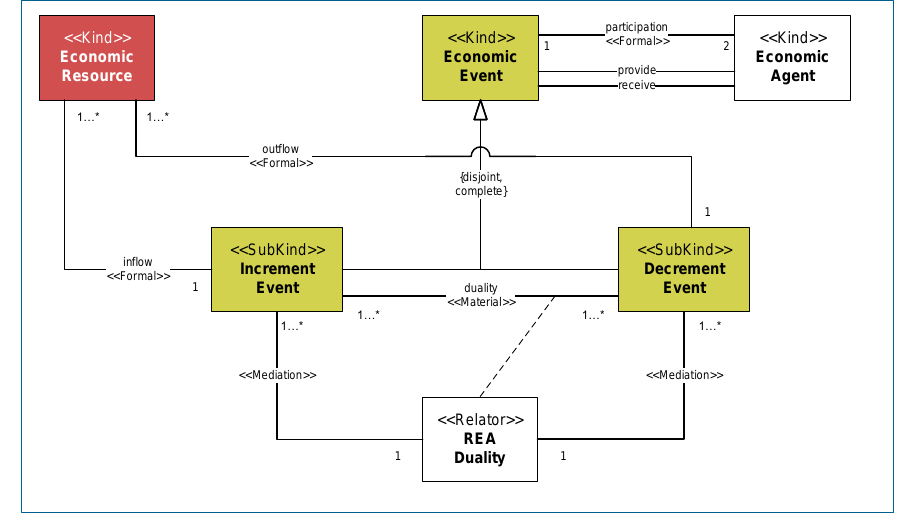
Figure 11. REA Accounting model – OntoUML